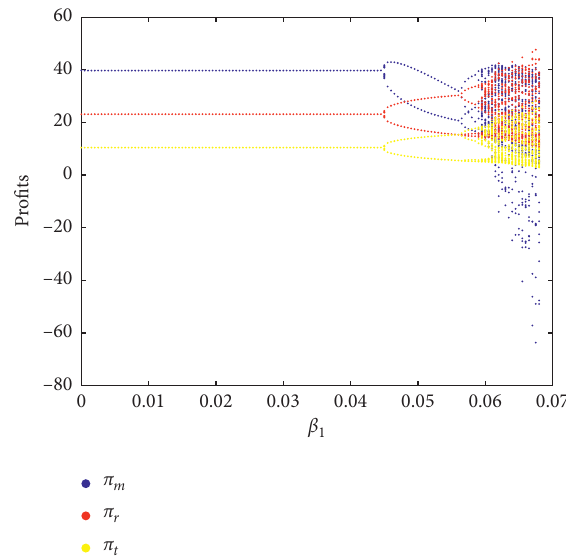
Figure 8: Bifurcation diagram of profits when β